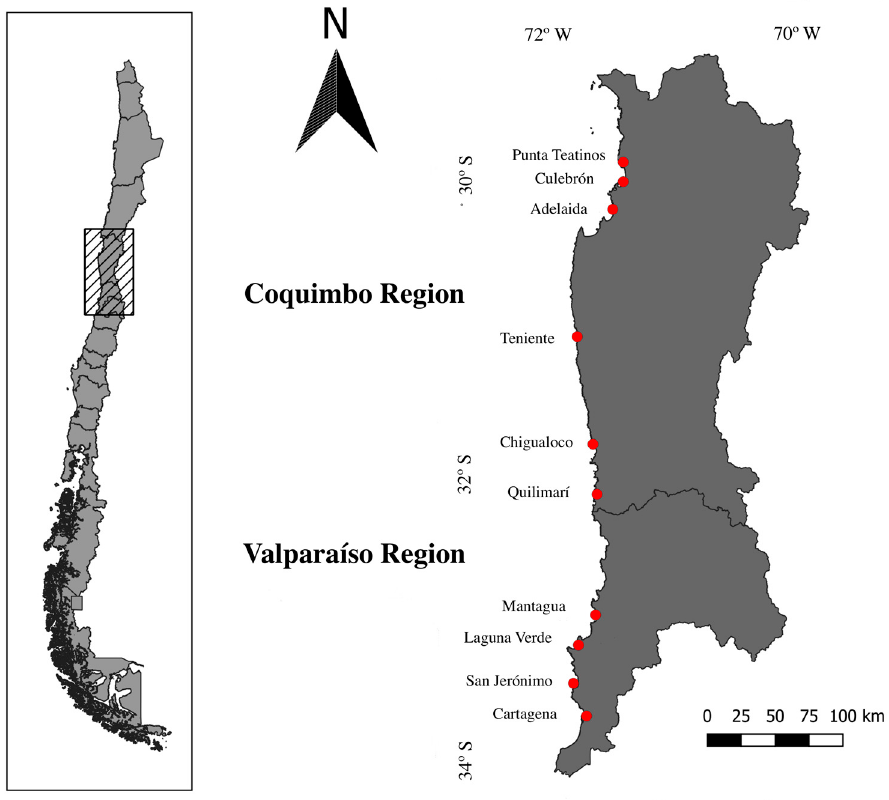
Figure 1. Map showing the distribution of the 10 study wetlands.